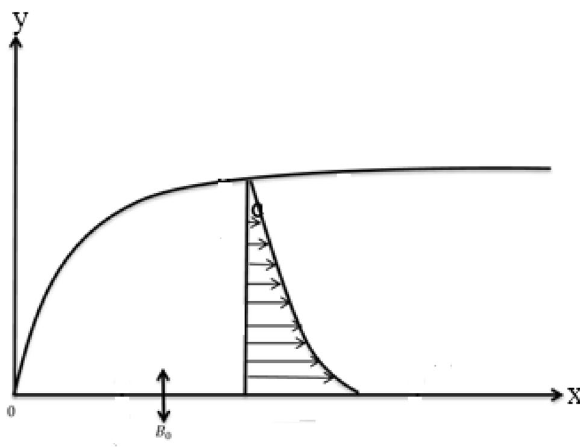
Figure 1. Geometry of the mathematical